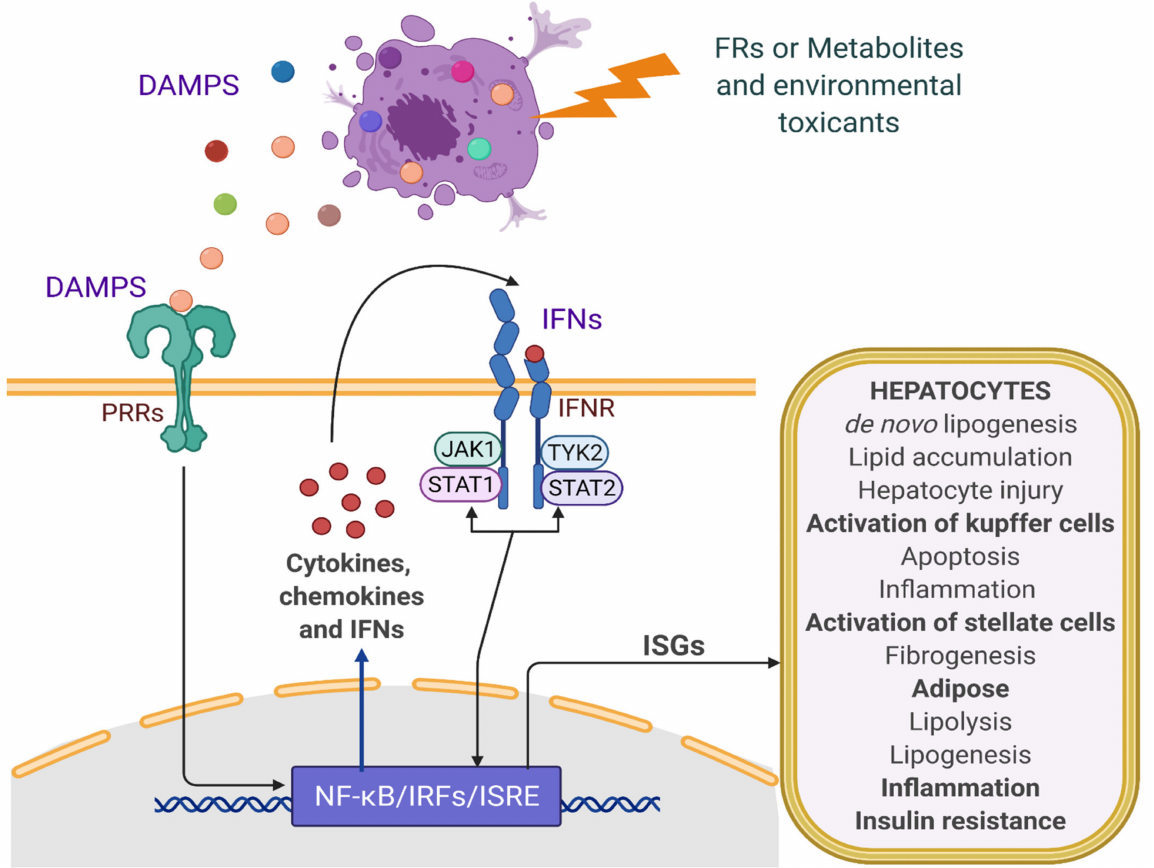
Figure 3. Scheme showing role of FRs-mediated cytokine and IFNs production and potential contribution in the progression of NAFLD. DAMPS are produced by damaged cells and bind to PRRs such as TLRs and NLRs, or cytosolic DNA sensors (cGAS), resulting in downstream signaling leading to activation of inflammatory mediators, cytokines, and IFNs. IFNs function through the respective IFN receptors and downstream JAK–STAT signaling, leading to the expression of interferon stimulatory genes (ISGs), which modulate many biological processes involved in the progression of NAFLD. (Created with